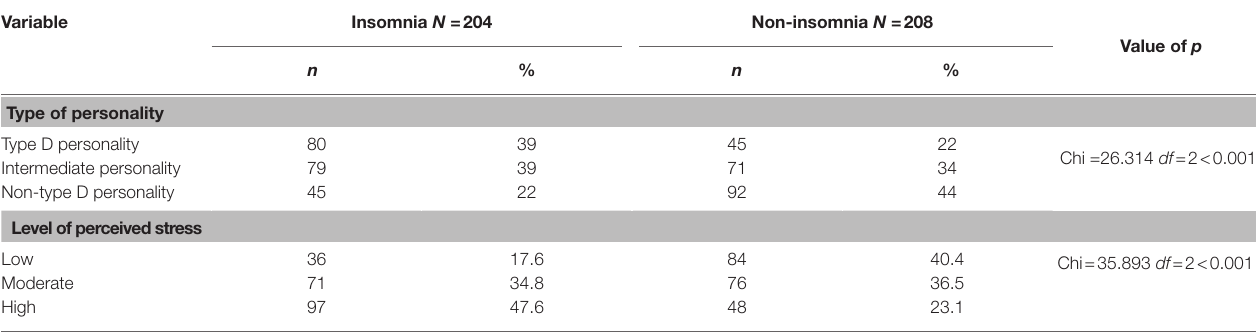
TABLE 4 | The incidence of insomnia among the studied group of teachers, including the type of personality and the level of perceived stress. Variable